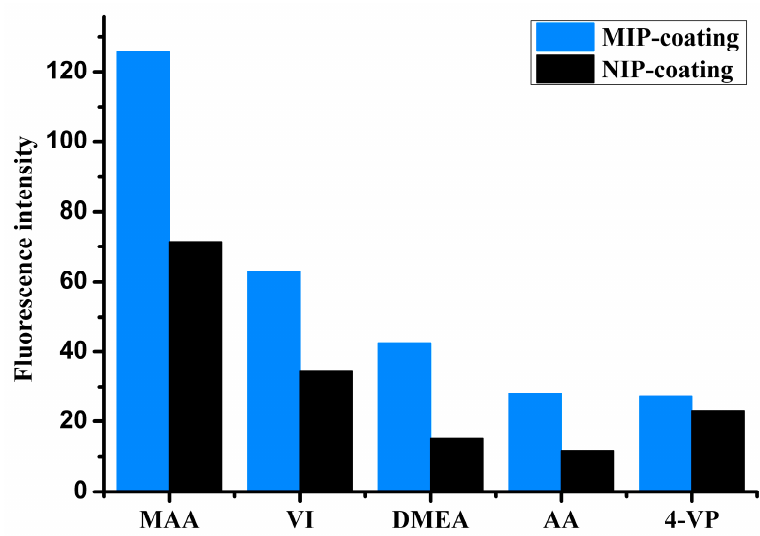
Figure 2. Chip fluorescence intensity for the different monomers used in the polymer coatings (5 mg · L − 1 IBA solution in chloroform, λ ex/em = 294/370 nm).